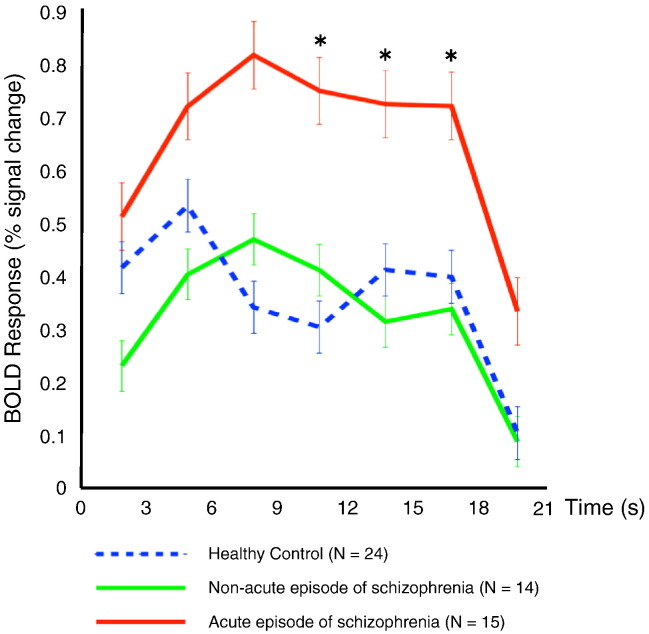
The time course of the 80-Hz ASSR-BOLD percent signal change. The x-axis indicates time (s), and the y-axis indicates BOLD percent signal change. The blue dotted line, green line, and red line indicate the 80-Hz ASSR-BOLD percent signal change in the HC, NASZ, and AESZ groups, respectively. The AESZ group showed a significantly increased BOLD response from 9 to 18 s (*p < 0.05, corrected) compared with both the NASZ and HC groups.